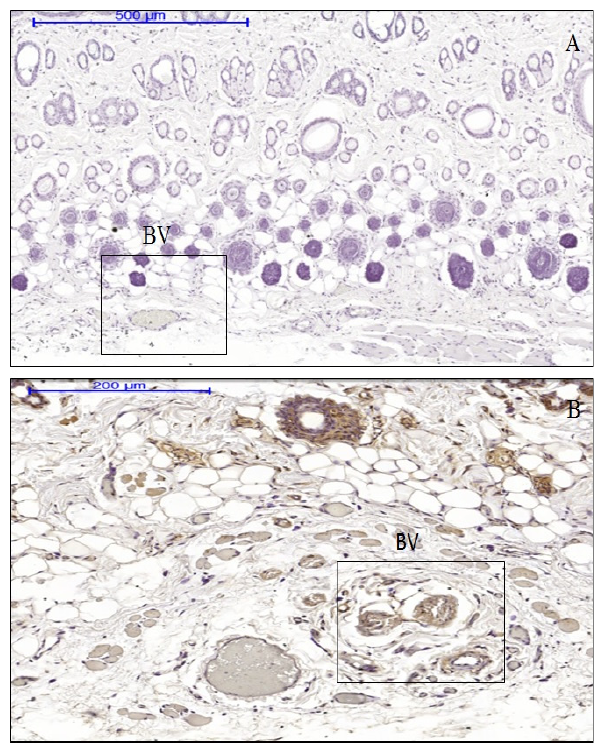
Figure 5. Comparison of IL-1 expression in the blood vessel regions in hypoderms. Endothelium cell in the hypoderm of the expanded tissues ( B ) showed strong positive staining for IL-1 (shown in boxes) compare to that in the controls ( A ). BV = blood vessels.